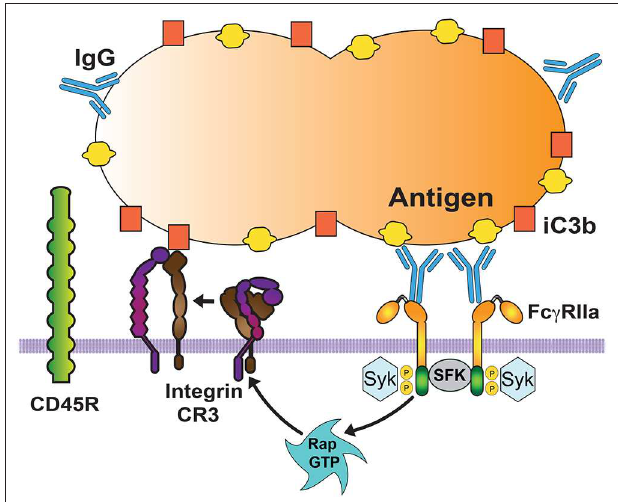
FIGURE 3 | Cooperation among phagocytic receptors. Most phagocytic receptors, such as receptors for antibody (Fc γ RIIa) and receptors for complement (Integrin CR3) cooperate to bind the particle to be ingested. Fc γ R aggregation triggers an inside-out signal that activates integrins via the GTPase Rap. Activated Rap (Rap GTP) is responsible for integrin activation. Then, activated integrins also bind to the particle (via complement